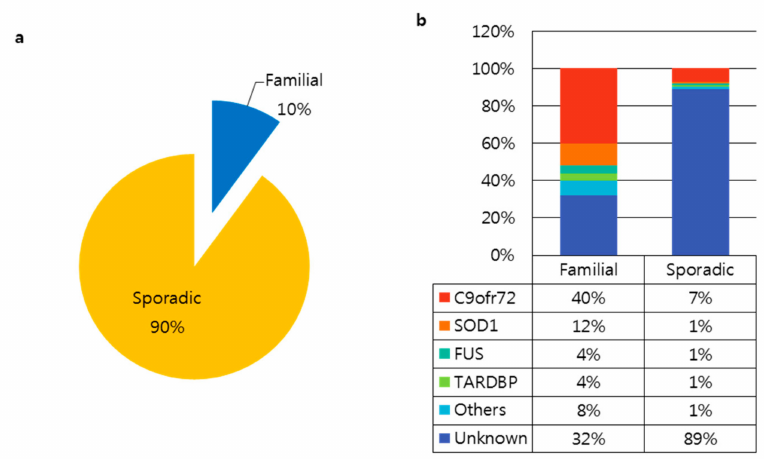
Figure 1. Genetic causes of amyotrophic lateral sclerosis (ALS). ( a ) Prevalence of familial and sporadic ALS cases. ( b ) Proportion of causative genes in familial and sporadic ALS